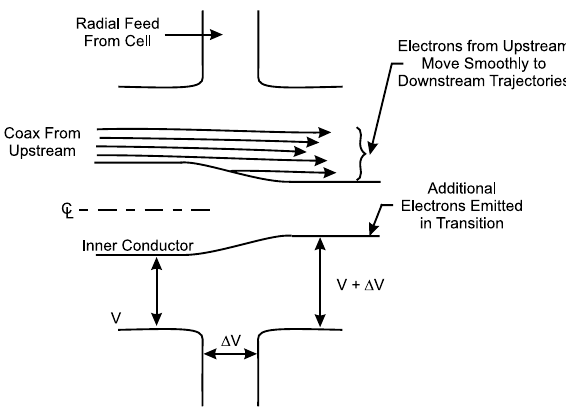
FIG. 15. Schematic of conductor and electric flow in ‘‘ideal’’ voltage